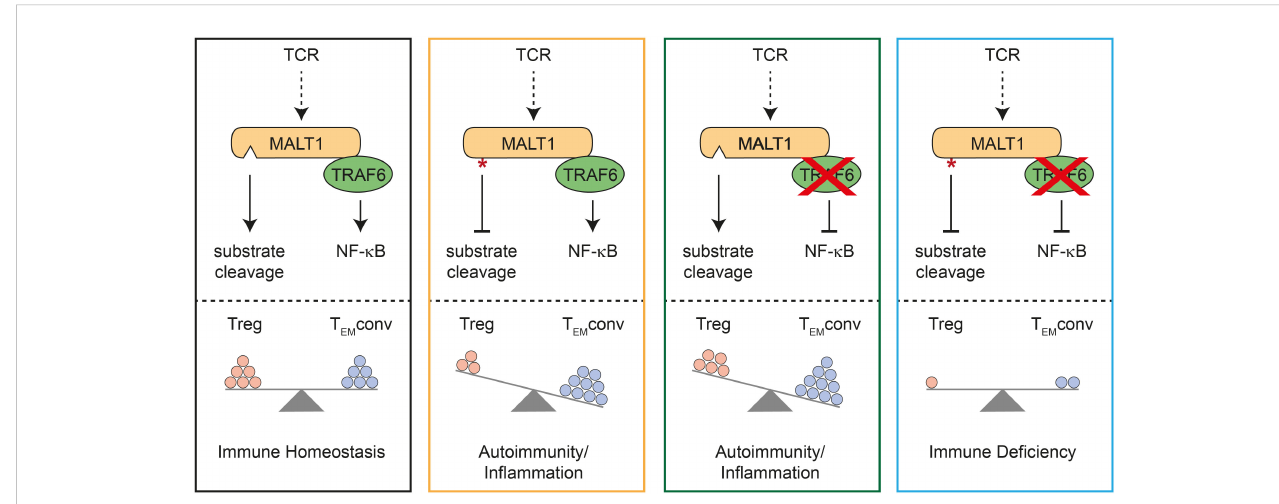
FIGURE 4 Schematic model for mutual control of homeostasis by MALT1 and TRAF6 in T cells. Effects of single or combined TRAF6 KO and MALT1 paracaspase mutation on NF- k B signaling and MALT1 substrate cleavage (upper part). Effects of single or combined mutations on regulatory T (Treg) and conventional T effector (T EM conv) cells, which determine the phenotypes of the mutant mice (lower part). Note that circles represent a combination of cell number and activation status in the different subsets.